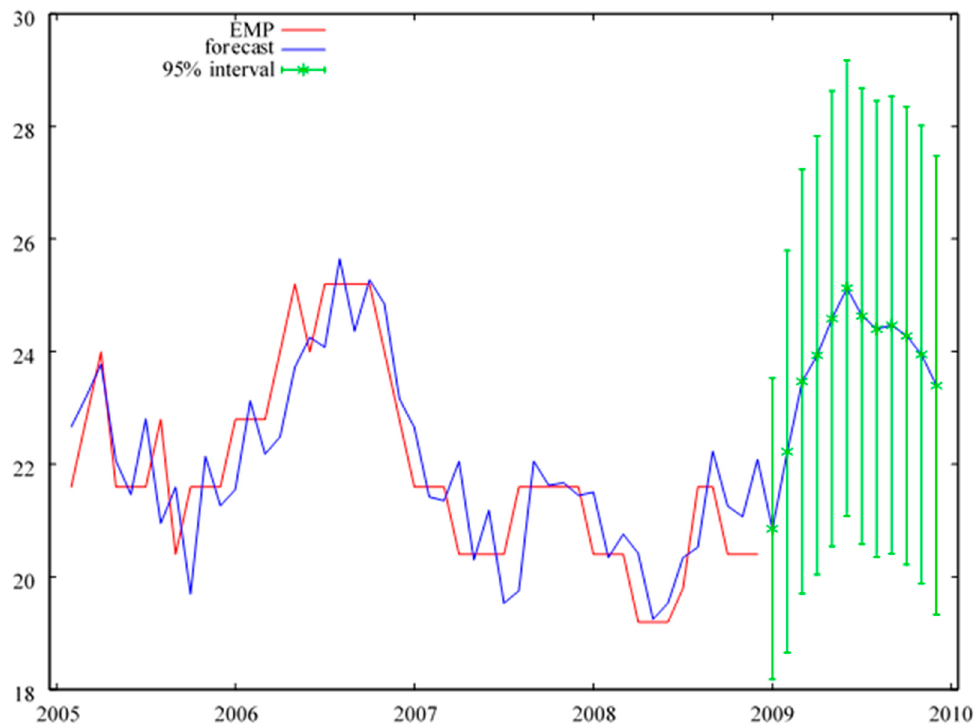
(s) EMP for the year 2009, in a system with an increase in the initial ( s ) for the year 2009, in a system with an increase in the initial Tp Tp